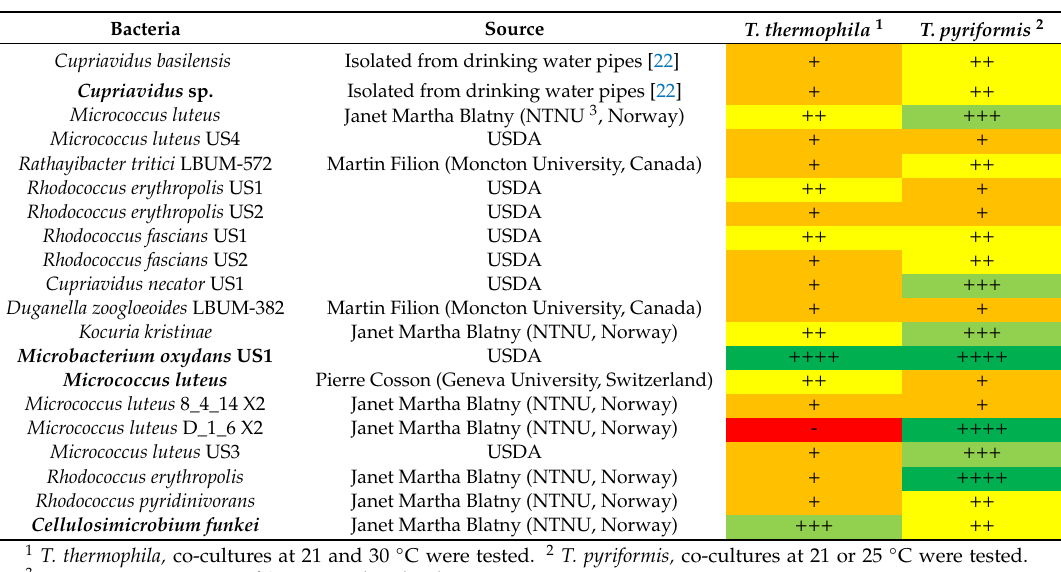
Table 1. Amoeba-resistant bacteria packaged by ciliates. Various non-pathogenic bacteria presenting an amoeba-resisting phenotype, as identified by Paquet et al., 2016, were co-cultured with two ciliate species. The production of bacteria-containing pellets was quantified by observing 10 fields at random on a microscope slide and counting the visible pellets. The extent of pellet production of each co-culture based on DIC observations is graded as follows: counts of 20 + visible pellets were considered excellent pellet production ( ++++ , dark green); 10–19 pellets were considered good ( +++ , light green); 3–9 pellets were considered intermediate ( ++ , yellow); and 0–2 pellets were considered mediocre ( + , orange). If no pellet was visible in the initial co-culture upon observation with an inverted microscope (-, red), it was considered that there was no pellet production and no slide was further prepared. Thus, the classifications from excellent to mediocre all yielded some pellets that were visible in the co-culture before sampling. Bacteria in bold were chosen for the rest of the pellet